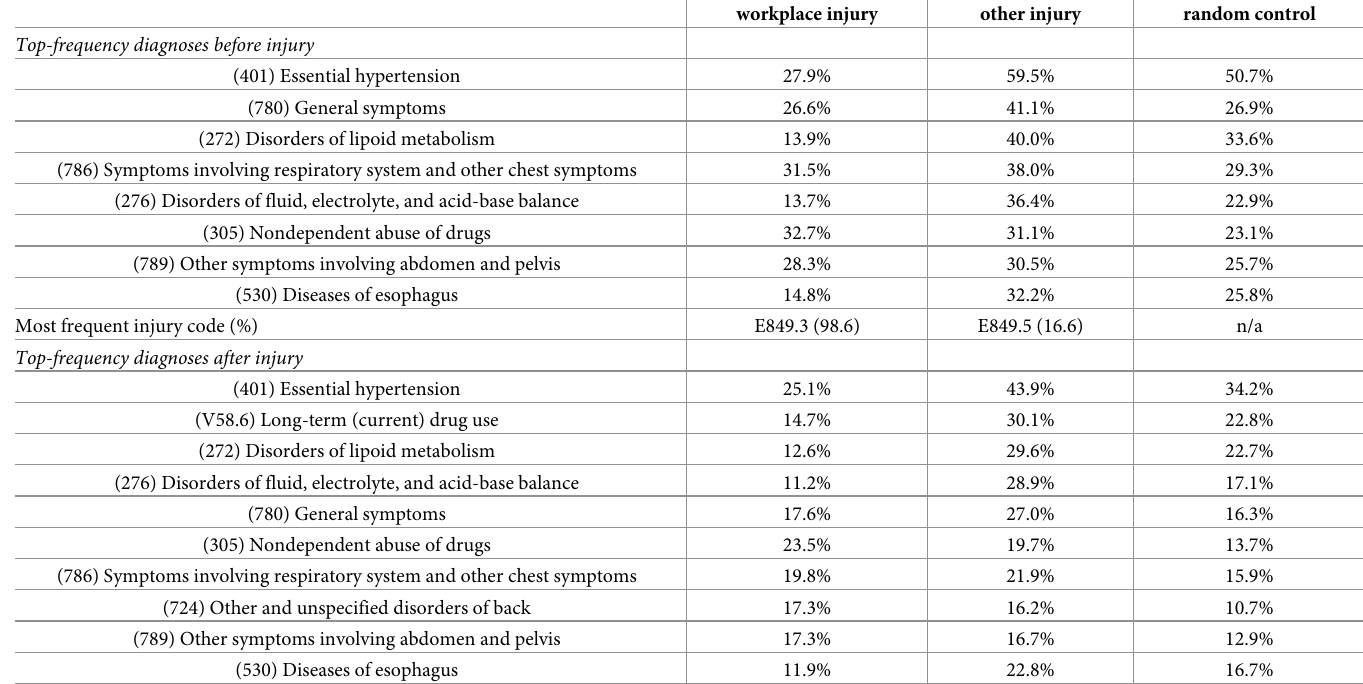
Table 2. Top-10 most frequent diagnosis in cases (before/after diagnosis).